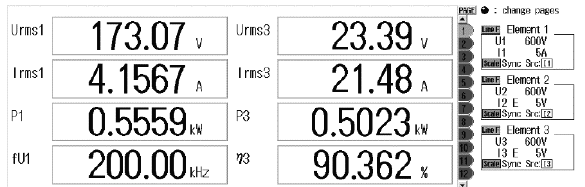
Figure 21. Output characteristics with UAV and nanocrystalline.